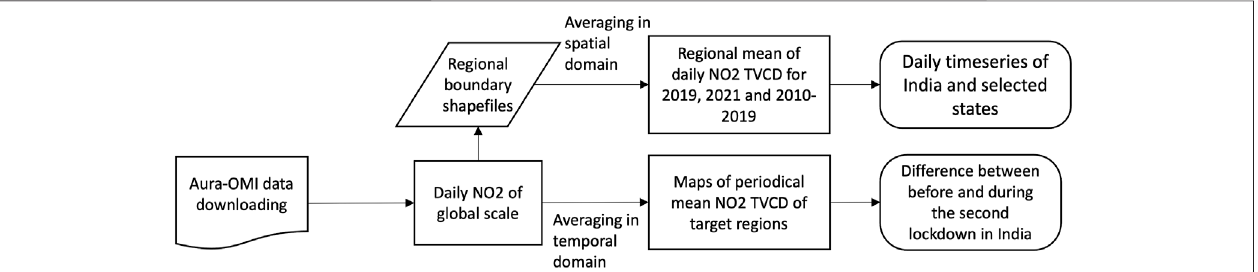
FIGURE 1 | Flowchart of the spatiotemporal analysis